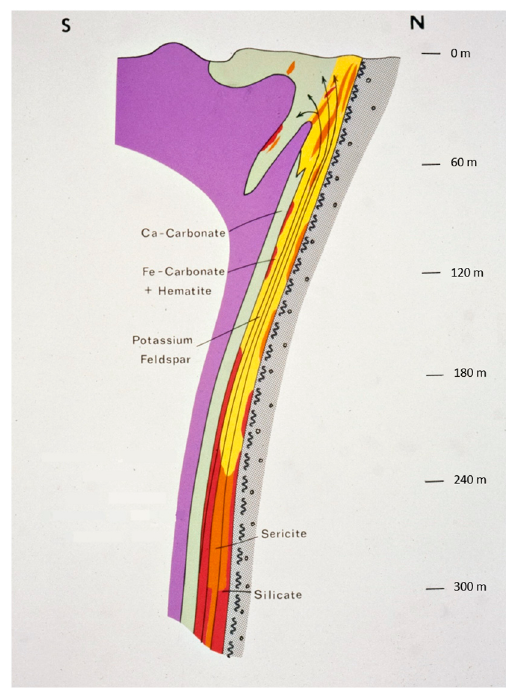
Figure 3. Schematic cross-section of the Brookbank deposits. Unit colors as in Figure 2.